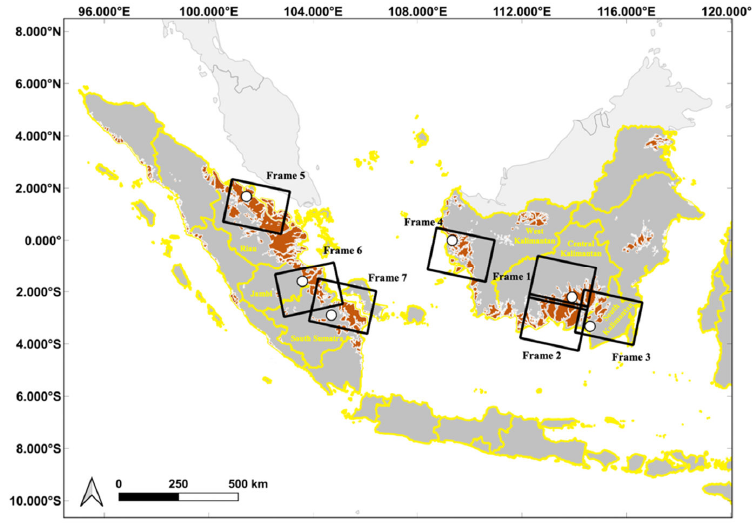
Figure 1. Study area over Kalimantan and Sumatra in Indonesia. Black rectangles indicate the Sentinel-1A frames processed in this study. The reddish-brown areas represent peatlands.